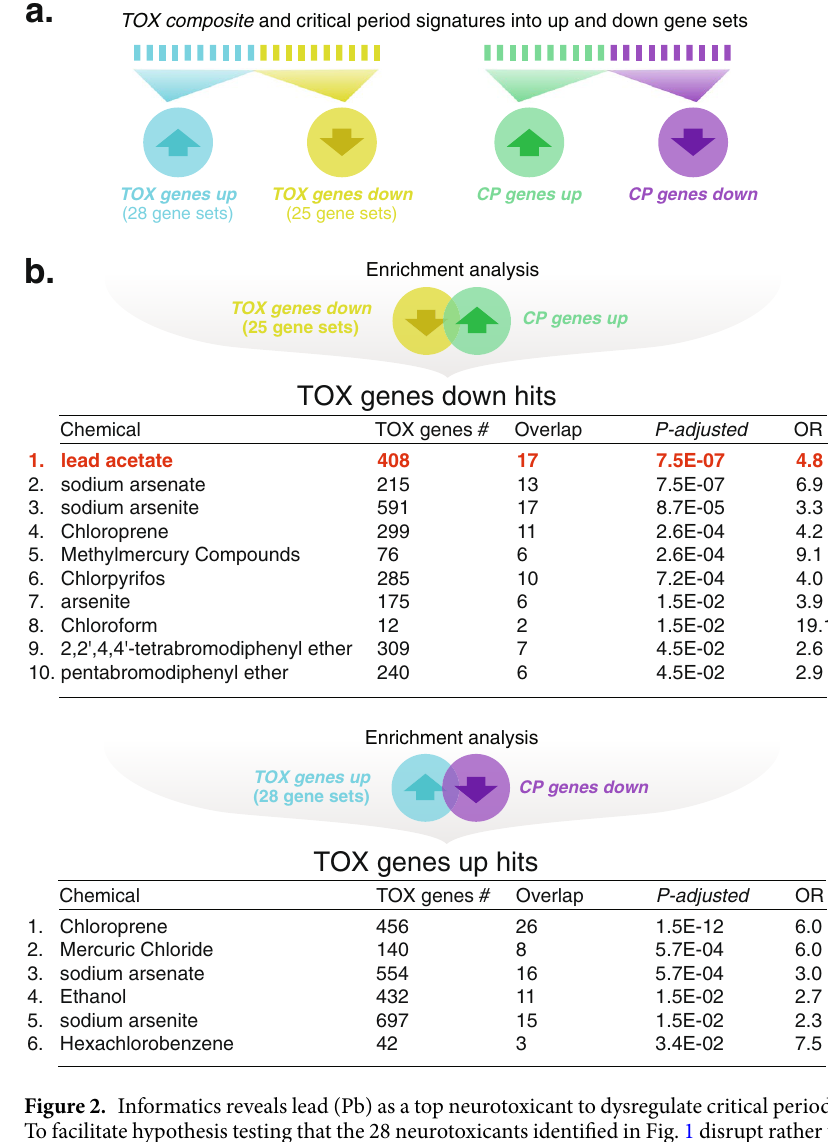
Adapting a molecular matching algorithm previously validated in brain 15 , we found that Pb at a dose that resulted in blood lead levels (BLLs) most relevant to human childhood exposure (~3 μ g/dL) 22 in rats fed Pb across postnatal devel- opment 19 decreased CP genes up (Molecular match score = − 3.07, P = 0.0039), recapitulating the CTD findings. This effect was specific to brain, as zero of 55 non-brain Pb transcriptional signatures derived from DrugMatrix significantly decreased CP genes up after multiple test correction, though there was a skew trending toward Pb signatures decreasing CP genes up (i.e. molecular match scores < 0), indicating some fundamental Pb-induced transcriptional mechanisms may be shared between brain and other tissues (D = 0.15, P = 0.083, Kolmogorov Smirnov test against a normal dis- tribution) (Table S5). Given the high and brain-specific ranking of Pb by our informatics analyses across independent datasets coupled with the current drinking water crises where elevated Pb poses serious neurodevelopmental conse- quences to developing children 23 , we focused our study on the role of Pb in disrupting critical period plasticity. (2018) 8:16388 | DOI:10.1038/s41598-018-34592-4